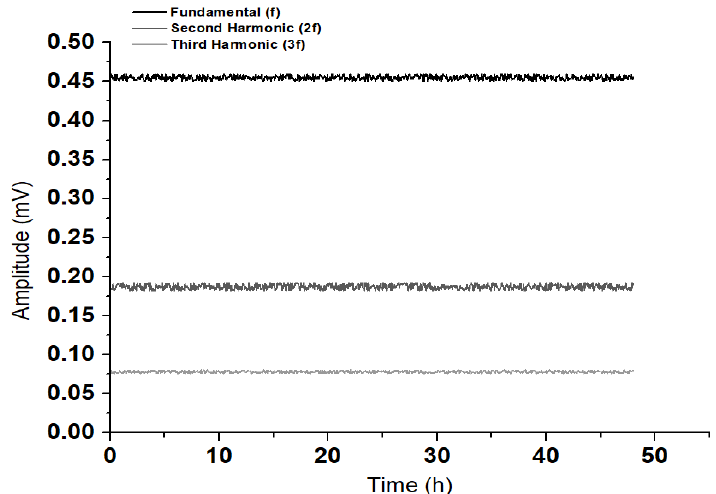
Figure 6. Temperature difference for various w/c ratios for ( a ) cement paste and ( b ) mortar.